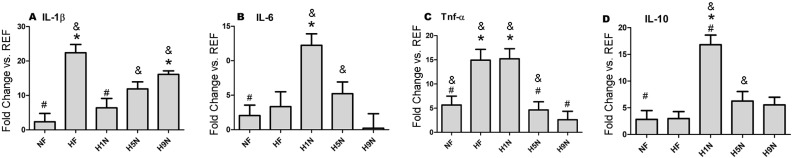
Different maternal diet intervention differentially affected the adipose tissue expression of inflammatory cytokine genes.(A-D)The gene expression level of Il-1β, Il-6, Tnf-α and Il-10 was measured by real-time PCR. The expression level was normalized against the REF group. Data is reported as Mean±SEM, n = 3–5. The “*” symbol indicates P<0.05 versus the NF group. The “#” symbol indicates P<0.05 versus the HF group. The “&” symbol indicate P<0.05 versus the REF group.